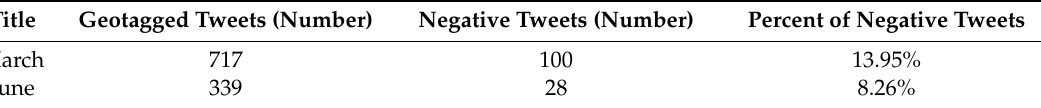
Table 2. Number of geotagged tweets in the UK.